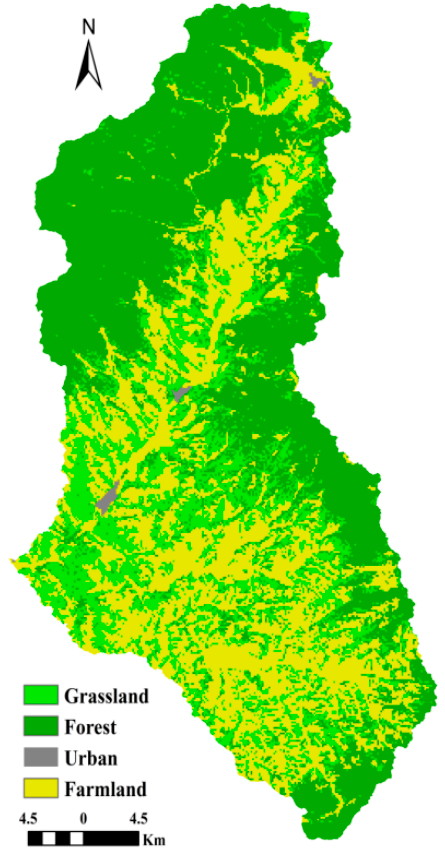
Figure 2. Land uses (farmland, urban, forest, and grassland) map for the 1980s in the Upper Honganjian watershed.